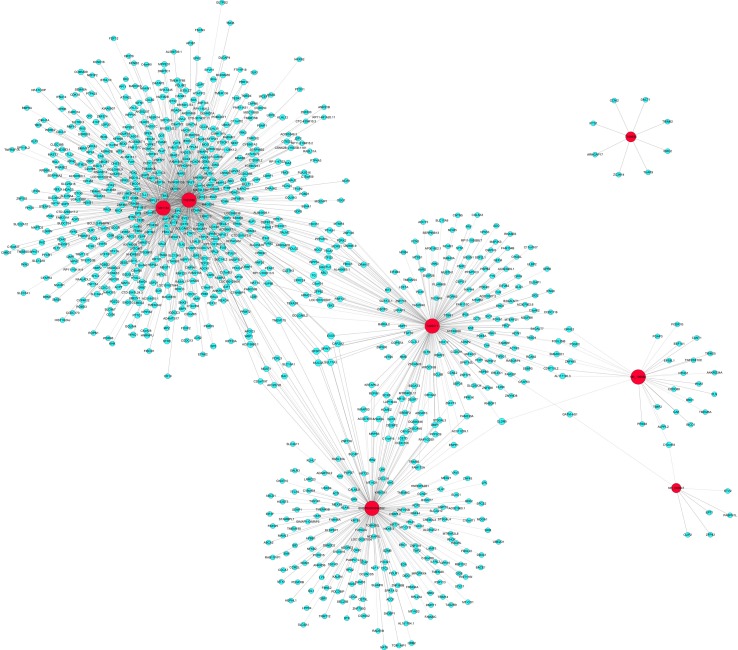
Coding–noncoding gene coexpression networks network of the seven validated long noncoding RNAs (lncRNAs) and their correlated messenger RNAs (mRNAs). The network represents coexpression correlations between seven lncRNAs and their correlated mRNAs. Red nodes represent lncRNAs. Blue nodes represent correlated mRNAs. The real lines between lncRNAs and mRNAs mean positive correlation, while the dotted lines mean negative correlation.